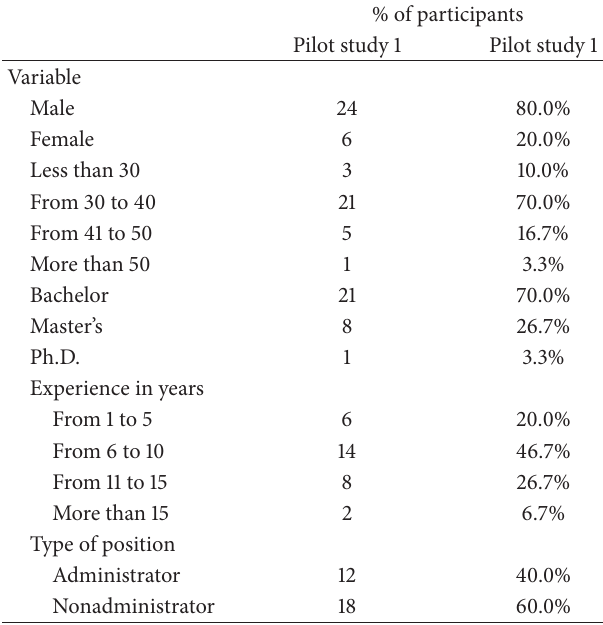
Table 2: Demographic characteristics.